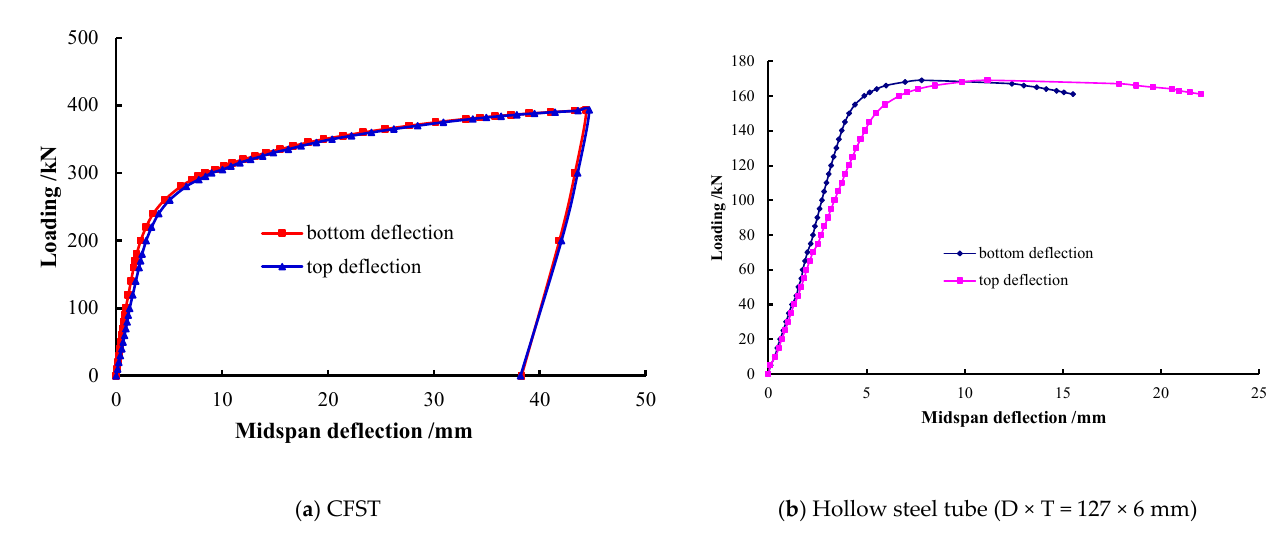
Figure 9. Comparison of deflection at the top and bottom of sections.